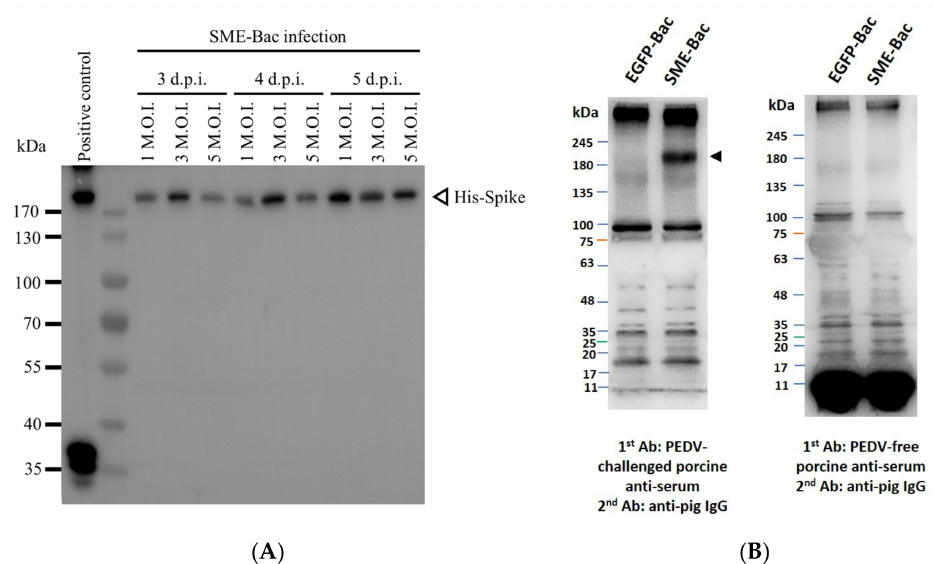
Figure 2. The detection of PEDV spike (S) proteins in the infected Sf21supernatant in various virus-like particles (VLP) production conditions by Western blot. ( A ) The samples were purified by conducting sucrose cushion and detected by anti-His tag antibodies. Positive control was Sf21 cells infected with S-Bac. ( B ) The Western blots of the VLPs stained with PEDV-challenged porcine serum were conducted. The protein bands of PEDV S protein are indicated by arrow heads. The EGFP-Bac was the sample collected from Sf21 cells infected with pFastBac1-HM6H-P-2A-PnV339-eGFP-Rhir and acted as a negative control.